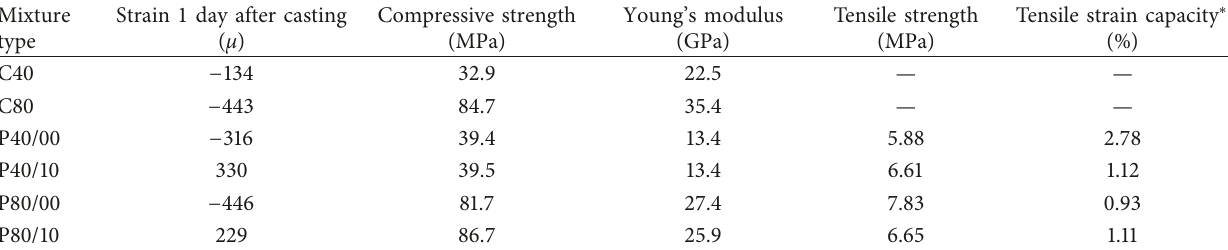
Table 4: Material properties of concrete and SHCC mixtures.